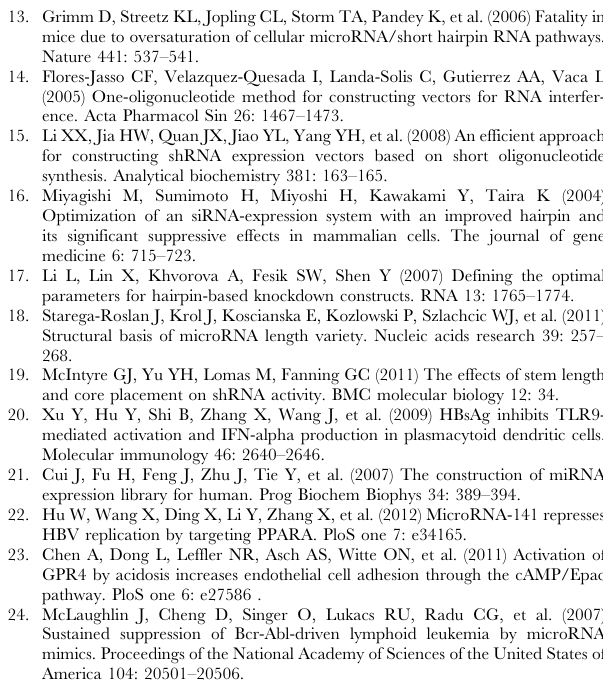
Figure S4 This pshOK shRNA system was compared with the popular used vector pSuper. The HBV target sequence ‘‘GGUAUGUUGCCCGUUUGUCCU’’ and the Gluc